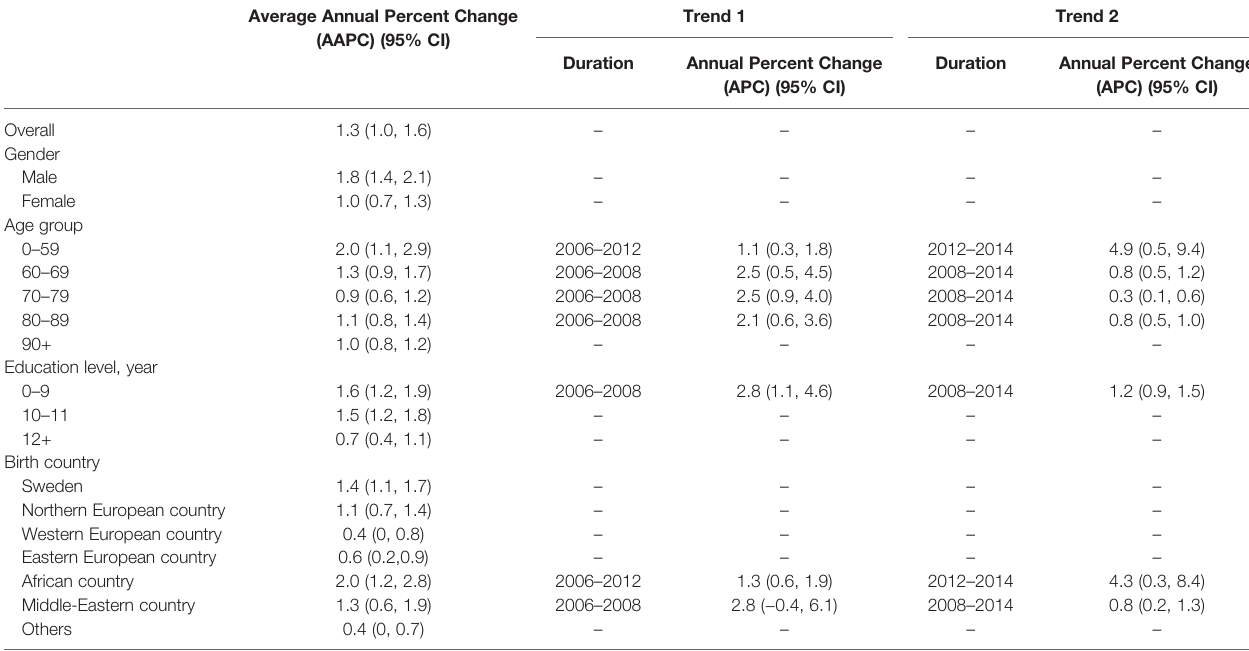
TABLE 4 | Results of joinpoint trend analysis for polypharmacy.